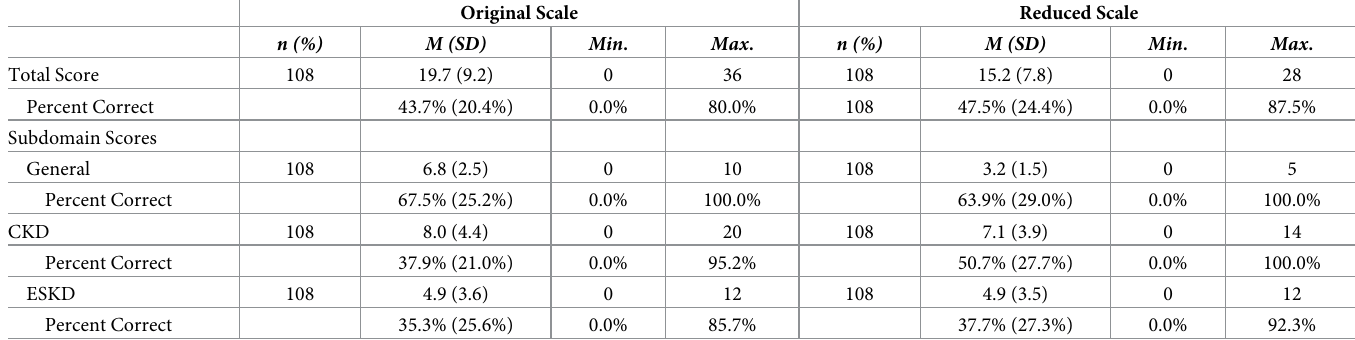
Table 5. Patient-level scale & subscale